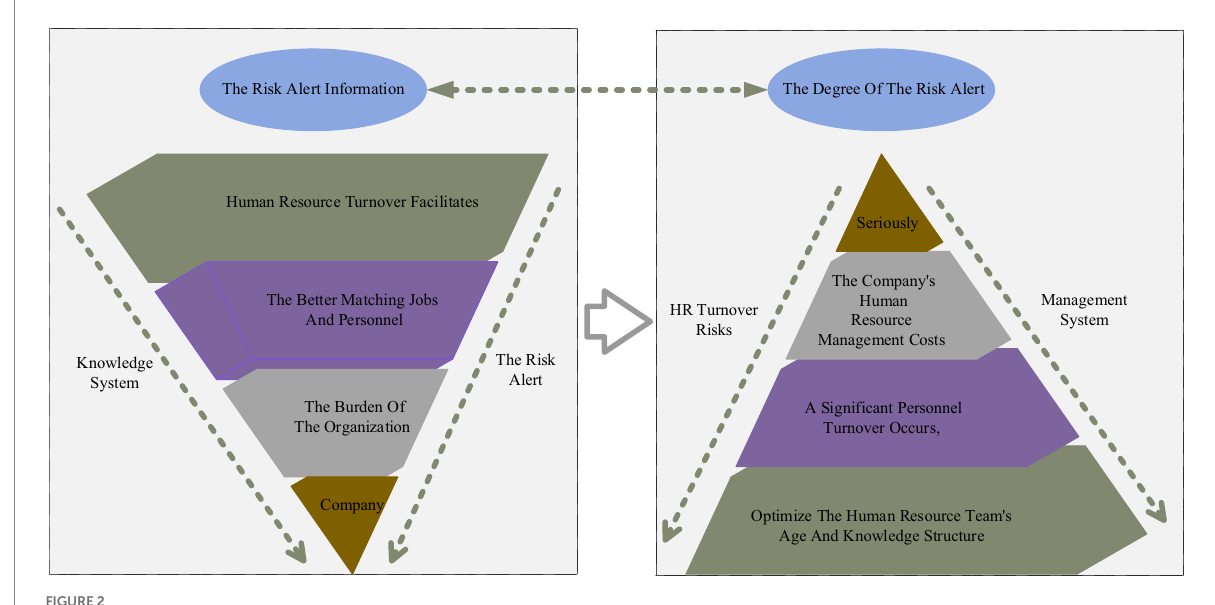
FIGURE 2 Framework of enterprise human resource turnover